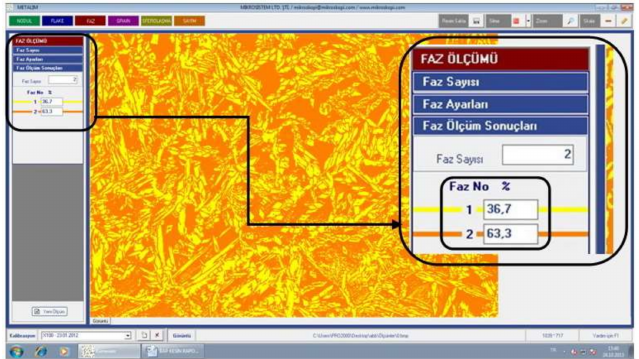
Figure 2. Image analysis of specimen welded with pure argon shielding gas (Specimen A), orange: δ -ferrite 63.3%, yellow: austenite